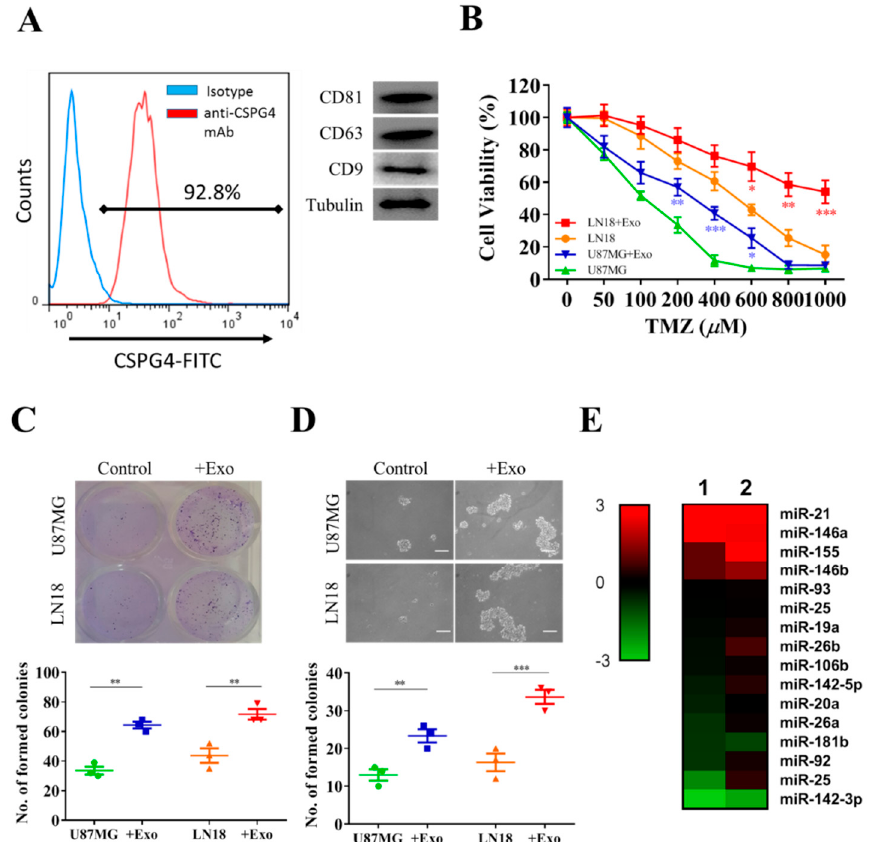
Figure 2. GAM-derived exosomes harbor miR-21, which promote GBM tumorigenesis. ( A ) Representative transmission electronic micrograph of exosomes isolated from clinical GAMs (left); Western blot validation of exosomes isolated from GAM culture medium showed the expression of CD9, CD63, and CD81. ( B ) Increased temozolomide (TMZ) resistance in U87MG and LN18 cells cocultured with exosomes (+exo). Enhanced colony-forming ability ( C ) and tumor-sphere-generating ability ( D ) in the presence GAM-derived exosomes. ( E ) MicroRNA profiling analyses showed that exosomes (two samples) isolated from M2 GAMs contained a high level of miR-21. Scale lengths = 100 μ m, * p < 0.05; ** p < 0.01; *** p < 0.001.